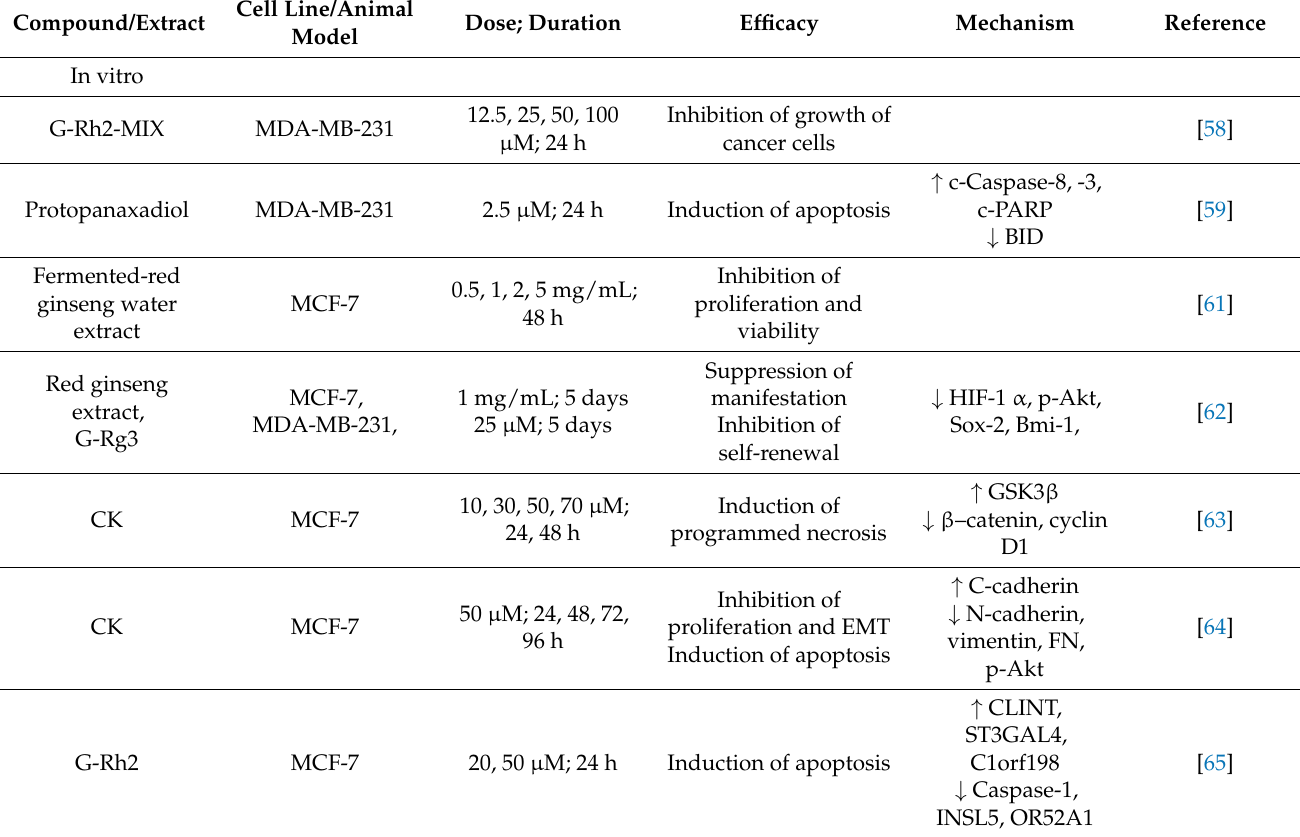
Table 2. Panax ginseng and its metabolites against breast